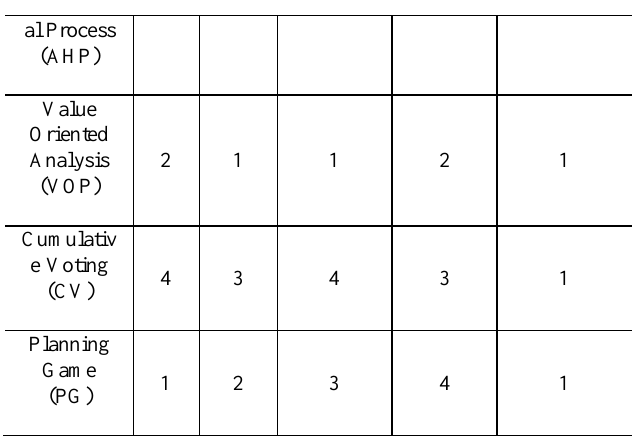
Figure 1. PGBLSs knowledge corpus